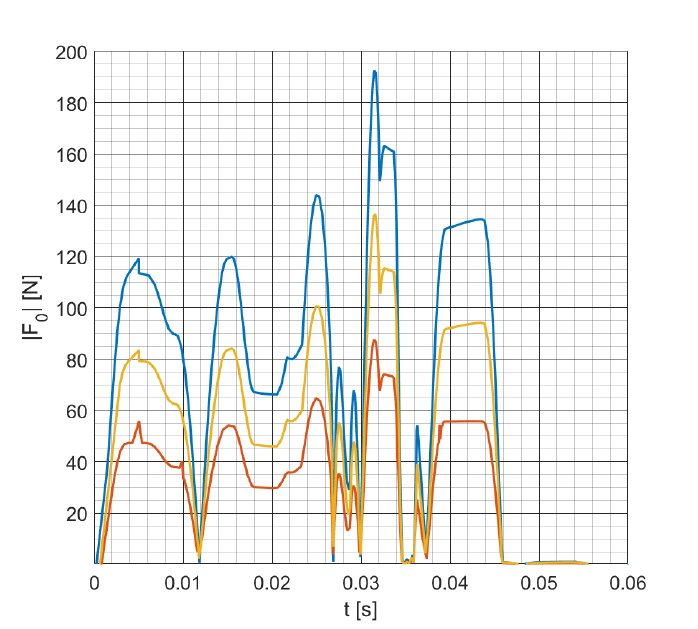
Figure 10. Magnitude of the base reaction F 0 : comparison between the initial design (blue), the reduced-mass design (yellow), and the length-optimized design